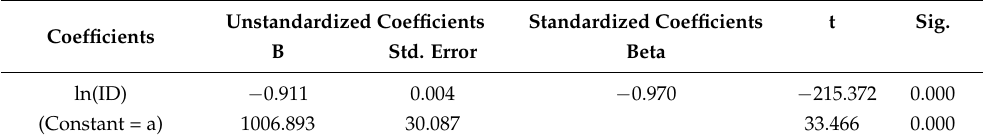
Table A3. Coefficients